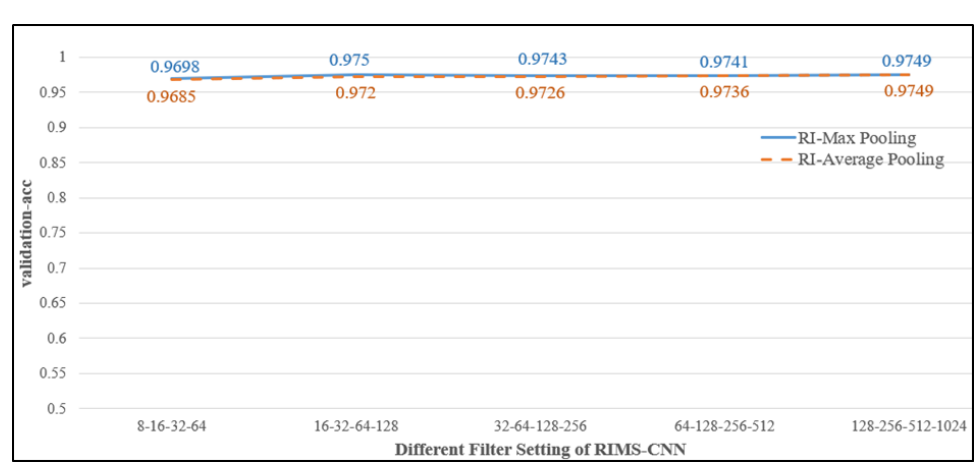
Figure 16. Comparing RI-max pooling with RI-average pooling on the fixed-angle rotated MNIST.